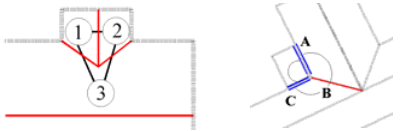
Figure 3: Convergence of Ridge-lines and Step-edges, at a closed cycle, (schematic diagram): red - ridges, blue - step-edges